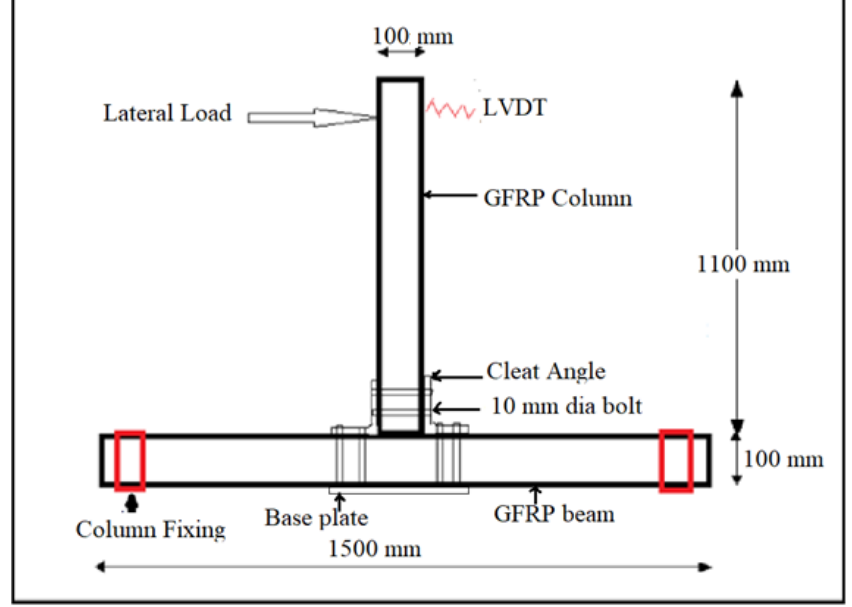
Figure 6. A schematic diagram of the experimental setup for beam-column testing. The test was conducted on a reaction frame of 200 kN capacity having a stroke length of 100 mm. A hydraulic jack attached to the load cell was used for the measurement of the applied load on the column, and an LVDT was used for the measurement of lateral displacement at the top of the column, as shown in Figure 7. The lateral load and the corresponding displacement readings were obtained from the data logger connected to a computer, which captured the values until the completion of the test. Cyclic loading was applied on the top of the column until the specimen